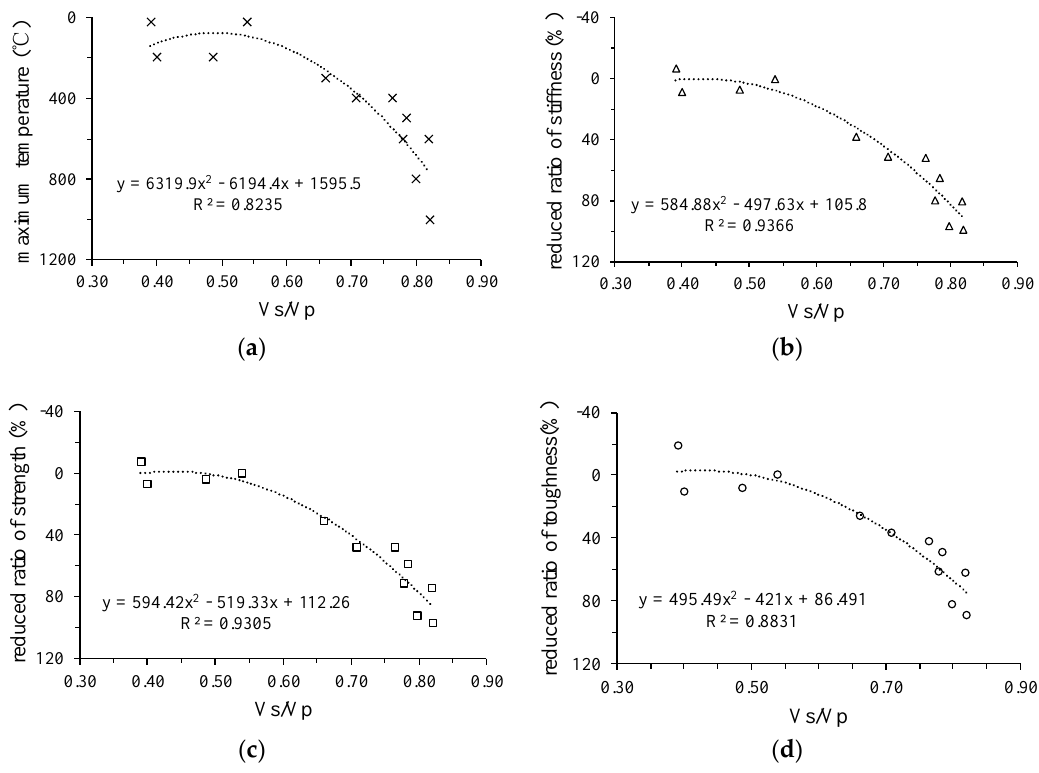
Figure 9. Correlation of wave velocity ratio (V S /V P ) to reduced ratio of ( a ) maximum temperature; ( b ) stiffness; ( c ) strength; ( d ) and pre ‐ peak toughness, respectively.